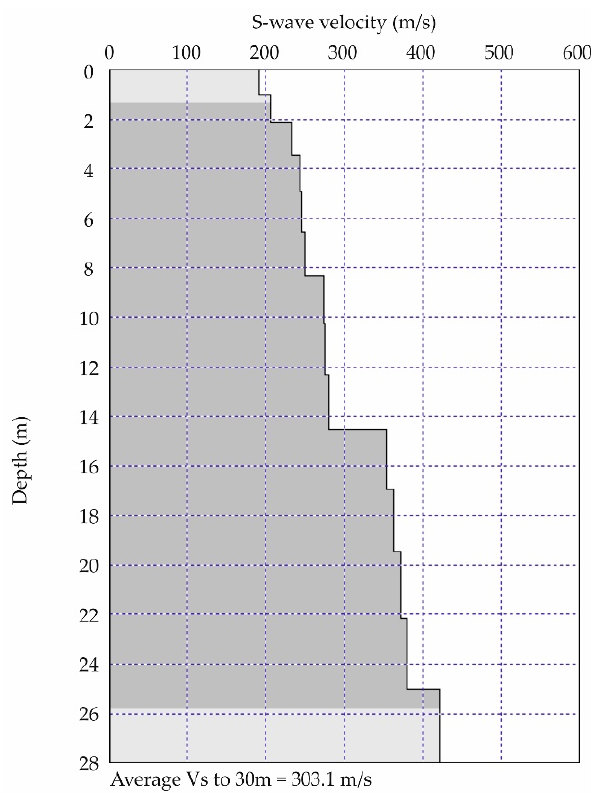
Figure A4. 1D Vs model derived from the MASW technique at LOUT station.